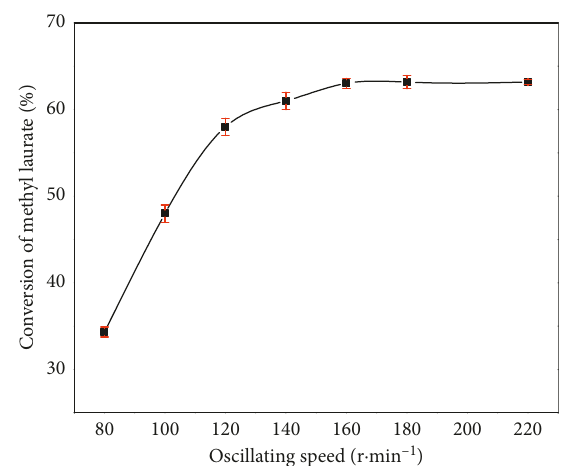
Figure 5: Effect of oscillating speed on lipase-catalyzed trans- esterification of decylglycerol with methyl laurate.